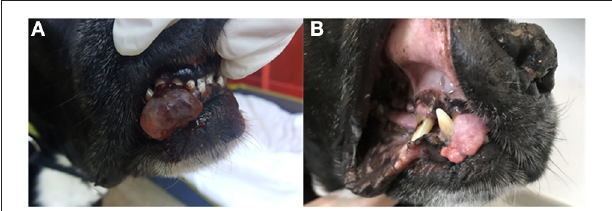
FIGURE 1 | Clinical images of patient no. 6 with an oral plasma cell tumor of the right rostral mandible before MC treatment (A) and 2 months after treatment initiation (B) . A partial response (PR) was observed after 90 days. The treatment was discontinued 170 days after initiation due to occurrence